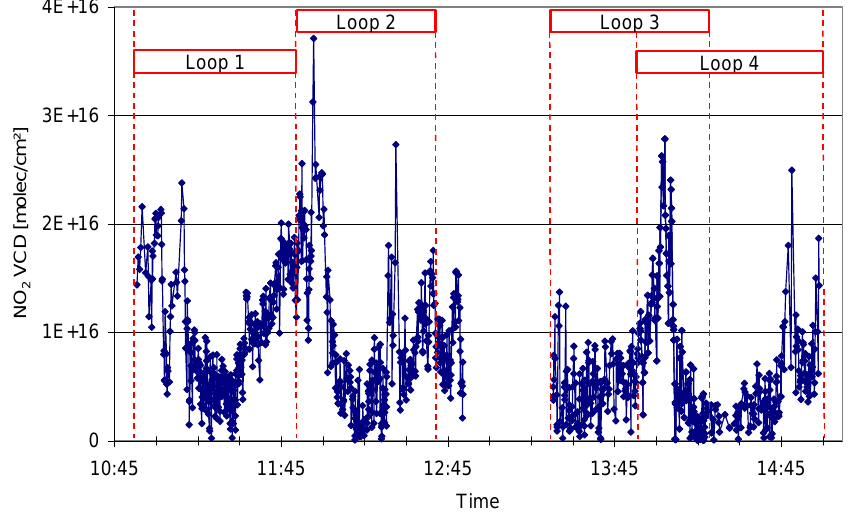
Figure 4 Time series (4 circles) of the NO 2 VCDs measured around Mannheim-Ludwigshafen area on 24.08.2006.